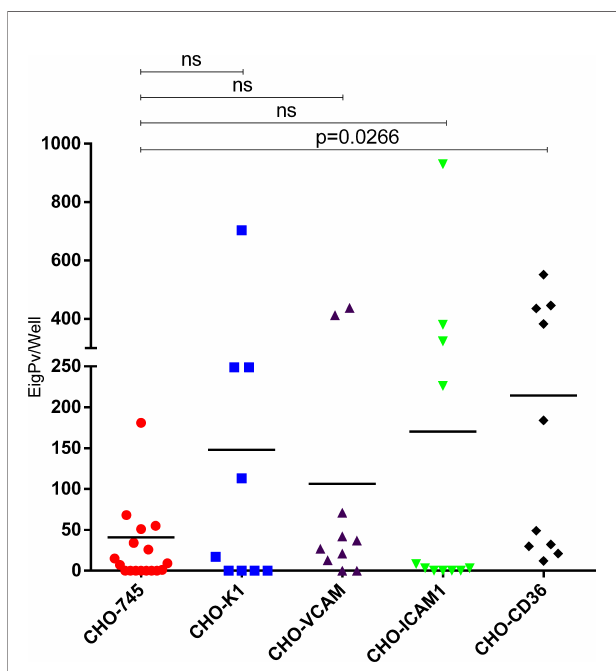
FIGURE 2 | Plasmodium vivax gametocytes adhesion to different endothelial receptors. Cytoadhesion assaysin CHO cells K1and CHO-745 (CHO-K1 depletedofglycosamynoglycans) and CHO-745 transfected with the endothelial receptors VCAM, ICAM1andCD36. Cytoadhesion was expressed as total gPv- pRBC adhered to CHO cells per well. Each symbol represents the mean adhesion rateof one isolate to the analyzedcell. The black line isthe mean adhesion rateof allisolates evaluatedto the respective CHO cell. The data were analyzed byKruskallWallisandDunns posttest. ns, not signi fi